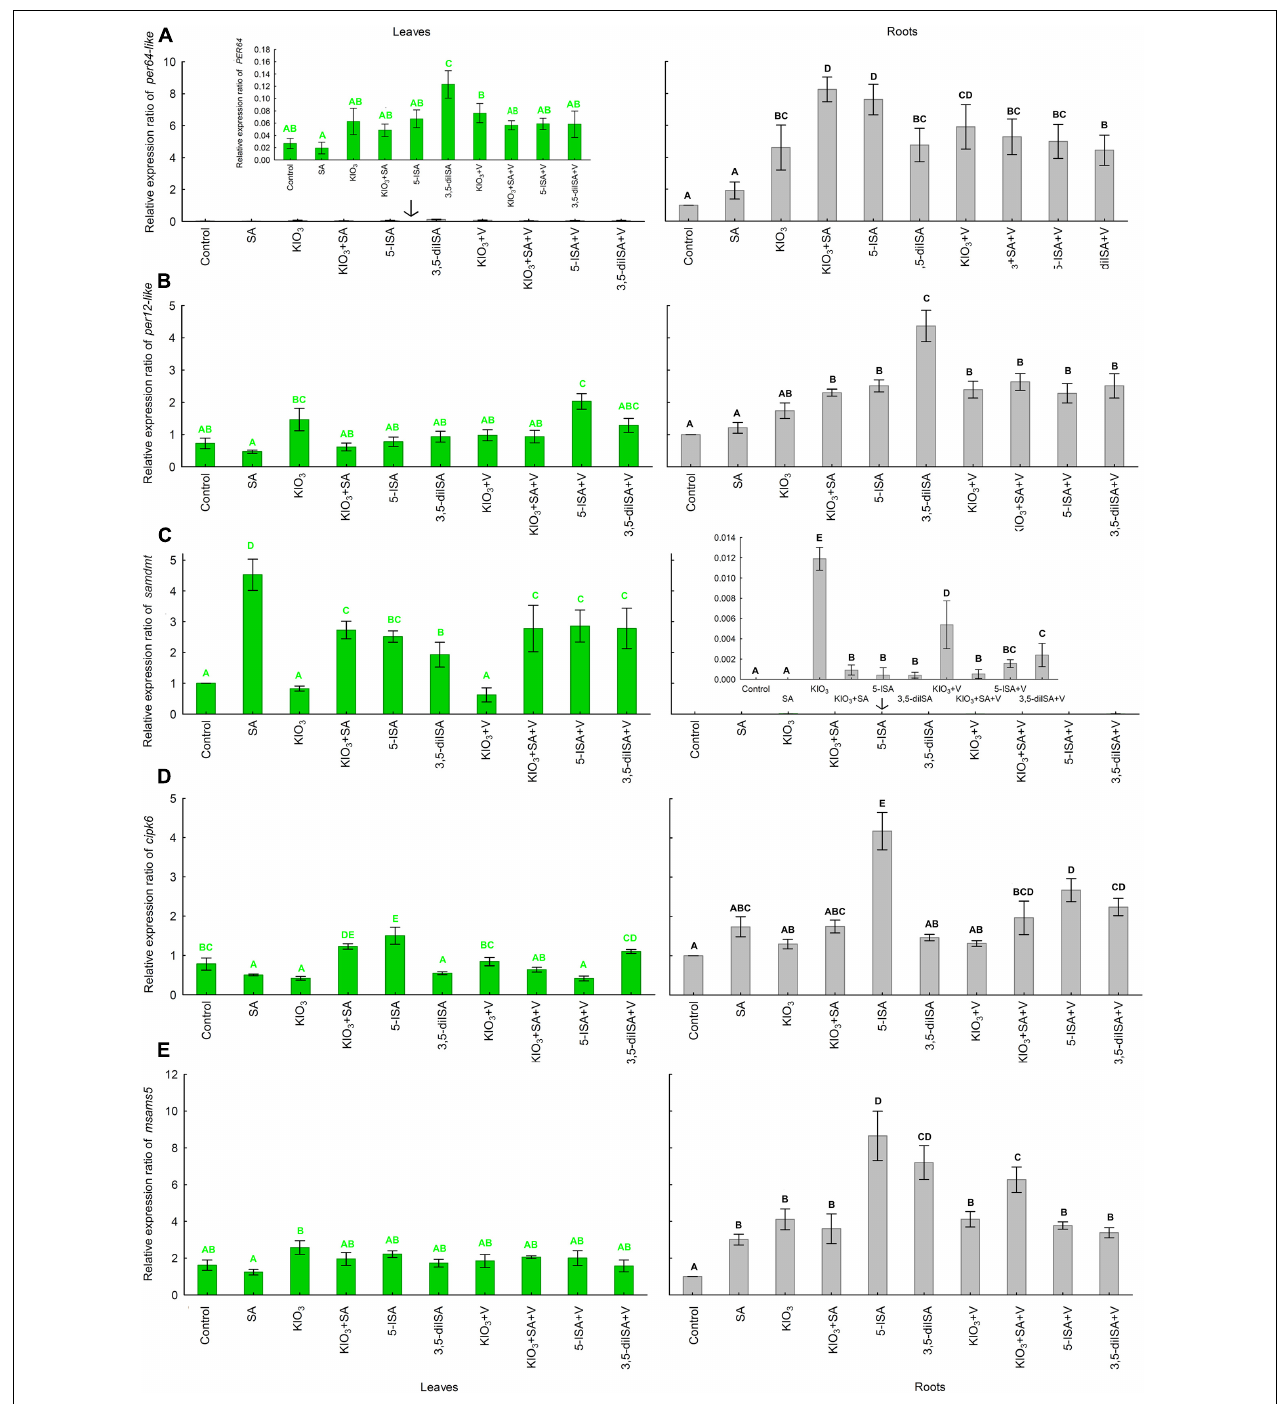
FIGURE 1 | Relative expression of per64-like (A) , per12-like (B) , samdmt (C) , cipk6 (D) , and msams5 (E) genes in leaves and roots of lettuce plants cultivated in hydroponic NFT Experiment No. 1. Means followed by different letters for treatments differ significantly at P < 0.05. Bars indicate standard error ( n = 4).